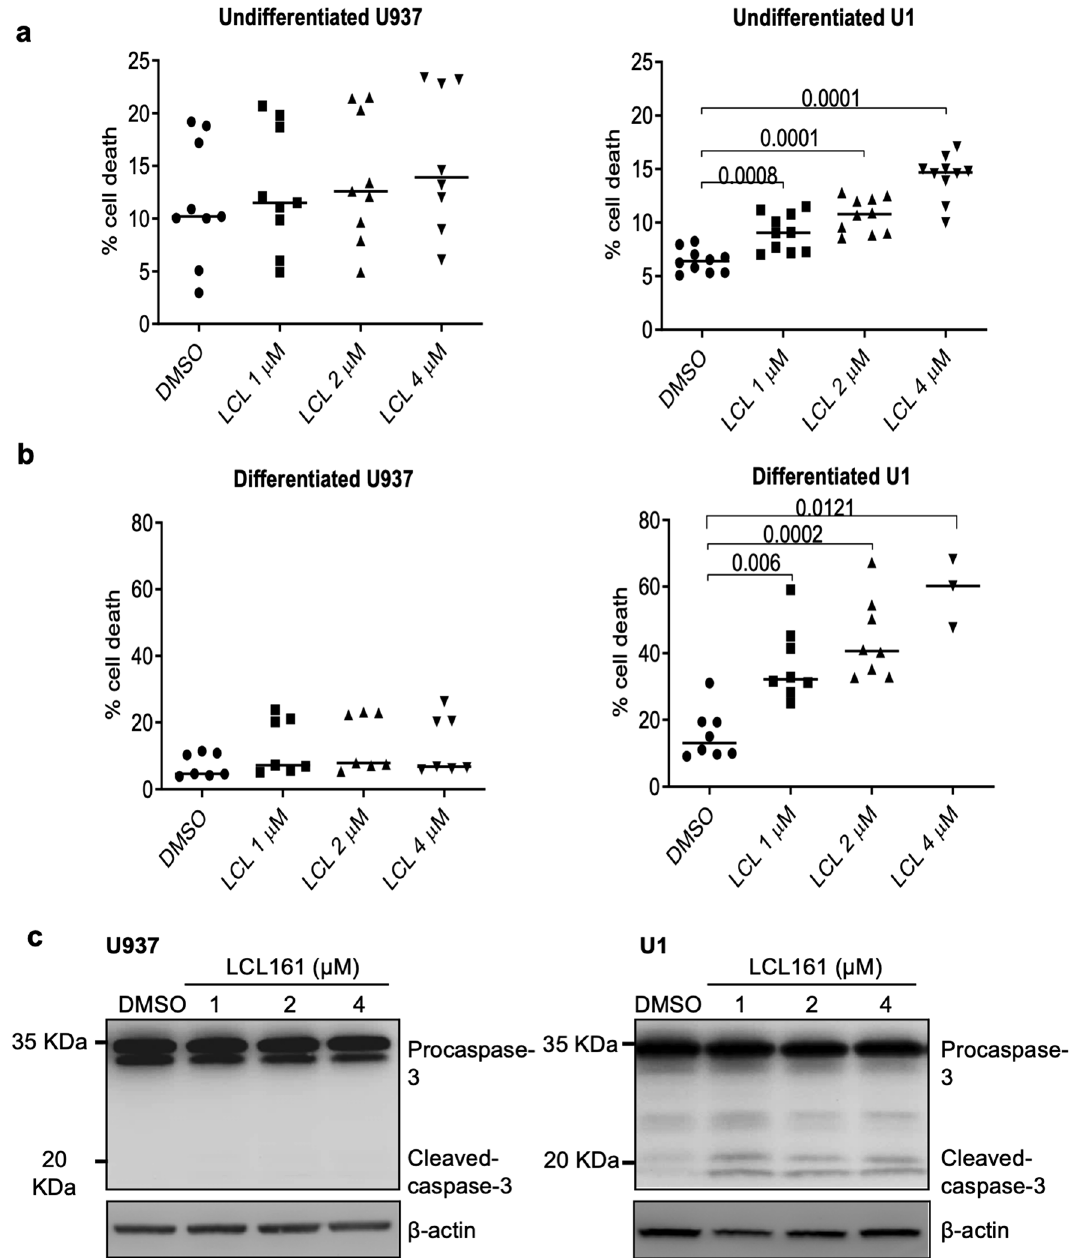
Figure 1. SM induces cell death of HIV-infected myeloid cells. ( a ) U937 (technical replicate (tn) = 9) and chronically infected counterpart U1 cells (5.0 × 10 5 ) (tn = 10) were treated with LCL161 at 1, 2, and 4 μM for 48 h. ( b ) PMA differentiated U937 (tn = 7) and U1 cells (tn = 11) were treated with SM LCL161 at 1, 2, and 4 μM for 48 h. Cell death was assessed by intracellular PI staining. The p -values were calculated using two- tailed Mann–Whitney U test. ( c ) U937 (tn = 2) and U1 (tn = 4) were treated with increasing concentration of LCL161 for 48 h and cytosolic fractions were collected and 30 µg of total proteins were subjected to western immunoblotting. The membranes were probed with antibodies specific for caspase-3. The uncropped western blot images are in Supplementary Fig. 6. The densitometric readings for figure ( c ) are shown in Supplementary Fig. fected, HIV exposed bystander macrophages) were analyzed for infection rate (% HSA + cells) and apoptosis as quantified by counter staining with Annexin-V labelled with BV711 expression. The gating strategy is shown in Fig. 3b. Analysis of infection rate (% HIV-HSA FITC + cells) following AEG40730 treatment did not reveal significant differences between control DMSO and AEG40730 treated macrophages (Fig. 3c, left panel). As a control, AEG40730 treatment did not show significant increase in non-specific FITC-HSA autoflourescence in mock uninfected macrophages (Fig. 3c, left panel). Representative histograms are shown (Fig. 3c, right panel).